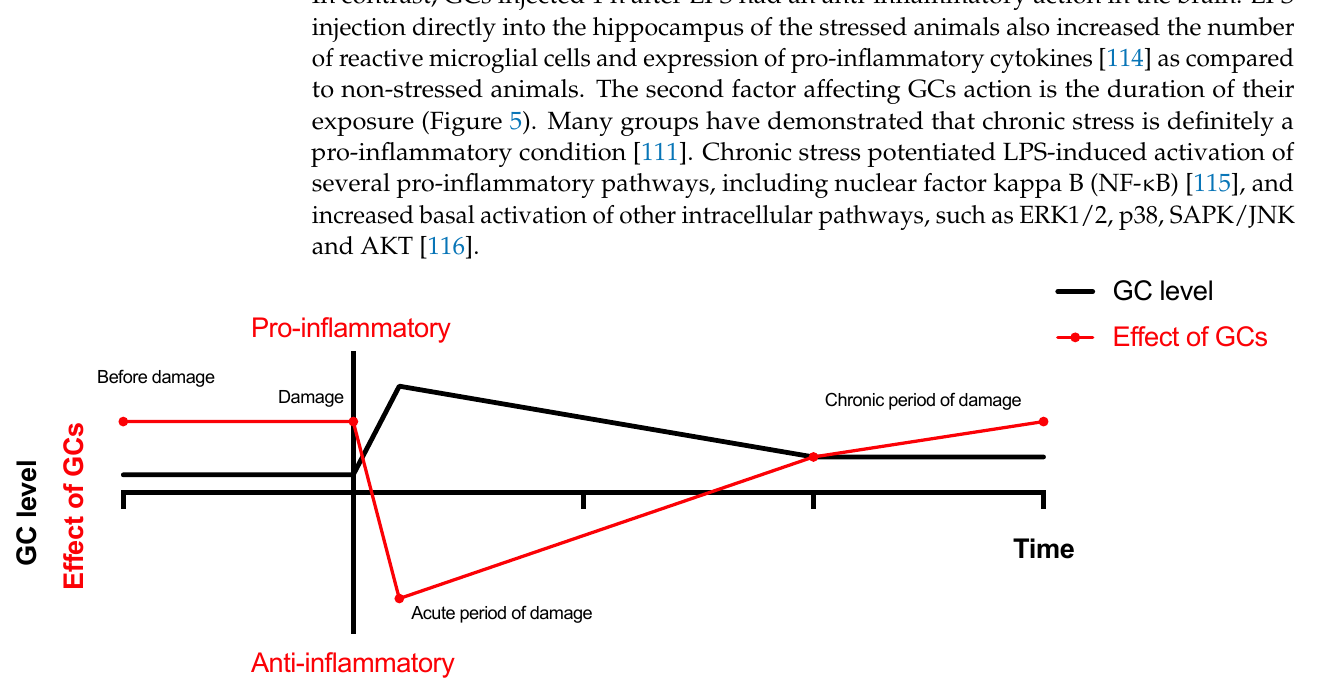
Figure 5. Effects of GCs on neuroinflammation depend on time of damage [54,55,111,113]. Timing of GCs exposure is critical for its pro- or anti-inflammatory action in the brain.